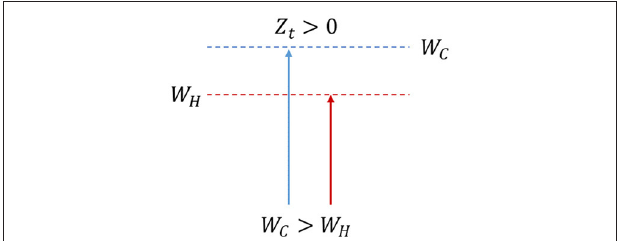
FIGURE 1 | The willpower effort exerted in the cold state is greater than the instinctual response given by the hot state; the individual derives the long-term utility.